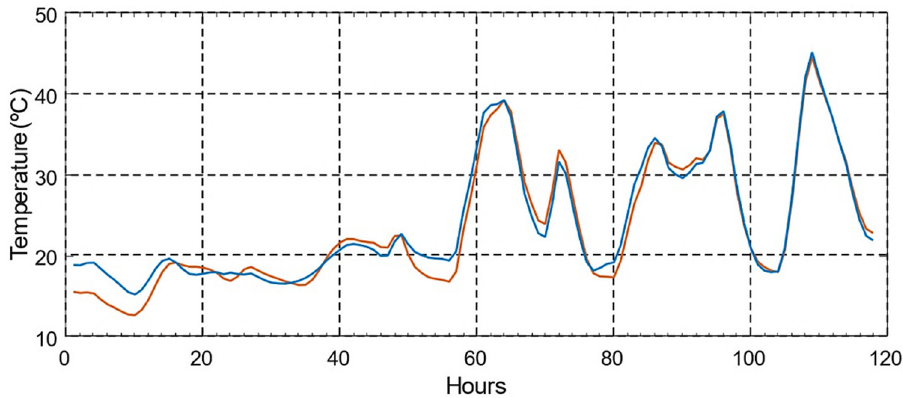
Figure 42. Oil temperature at the top of the oil through simulated (blue) and measured (orange) ambient temperature for January.